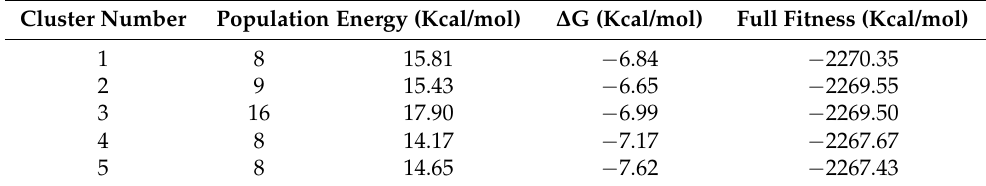
Table 1. Data obtained by molecular docking protocols with the SwissDock server. Cluster